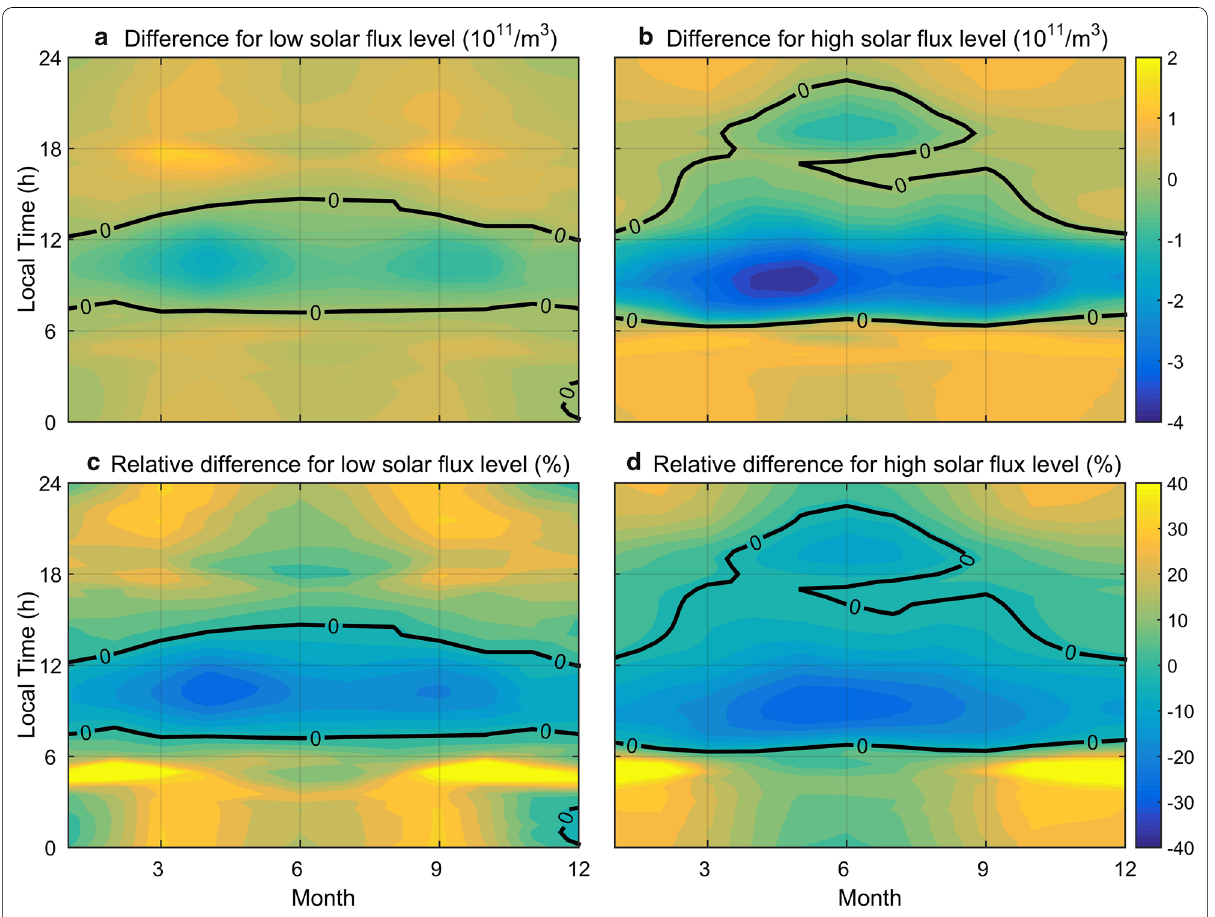
Fig. 4 The solar cycle variations of NmF2 east–west differences. The top and bottom plots, respectively, show the seasonal and diurnal variations of ΔNmF2 ( a , b , in units of 10 11 /m 3 ) and R ew ( c , d , in units of %). The left and right plots, respectively, show the east–west differences for a , c low and b , d high solar flux levels. The solid lines in these plots represent the zero